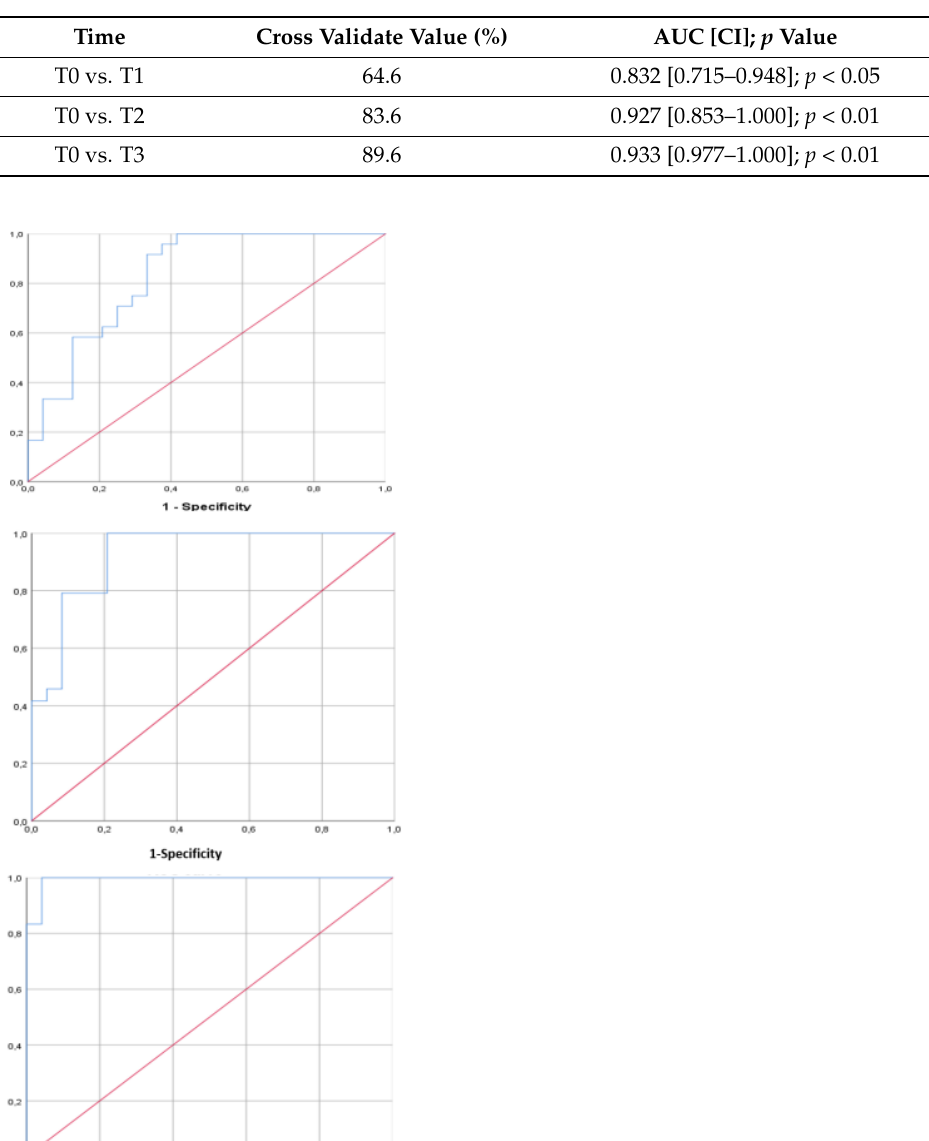
Table 3. Discriminant analysis by means of PC2 and PC4 between before smoking and after smoking time periods.